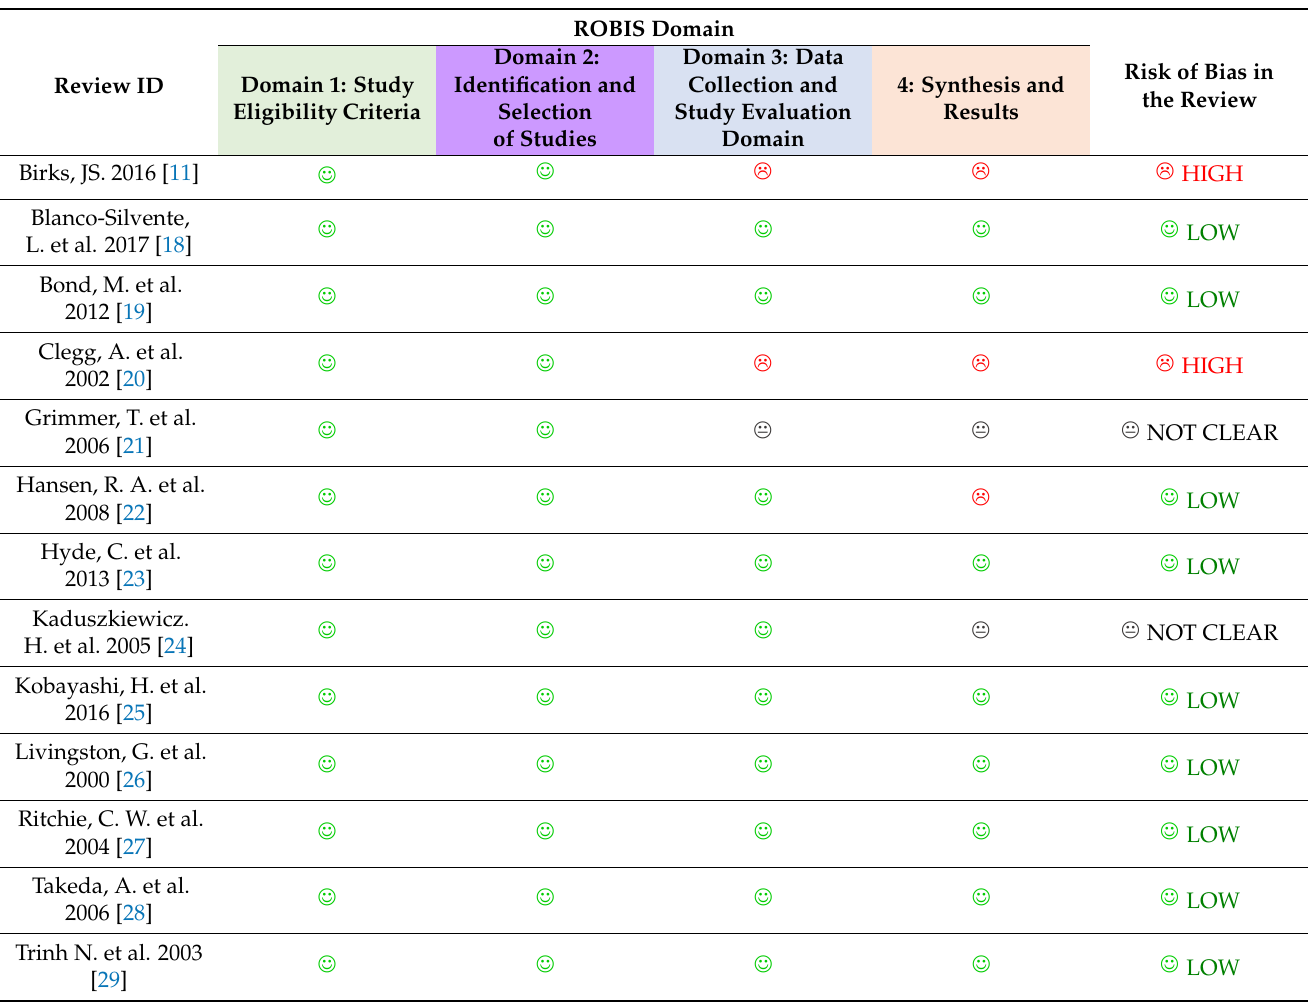
Table 1. Summary of the risk of bias of the included studies according to ROBIS. Justification for concern: Low: , if all answers are yes or probably yes. High: , if any is no or probably no. Not clear: , insufficient data.